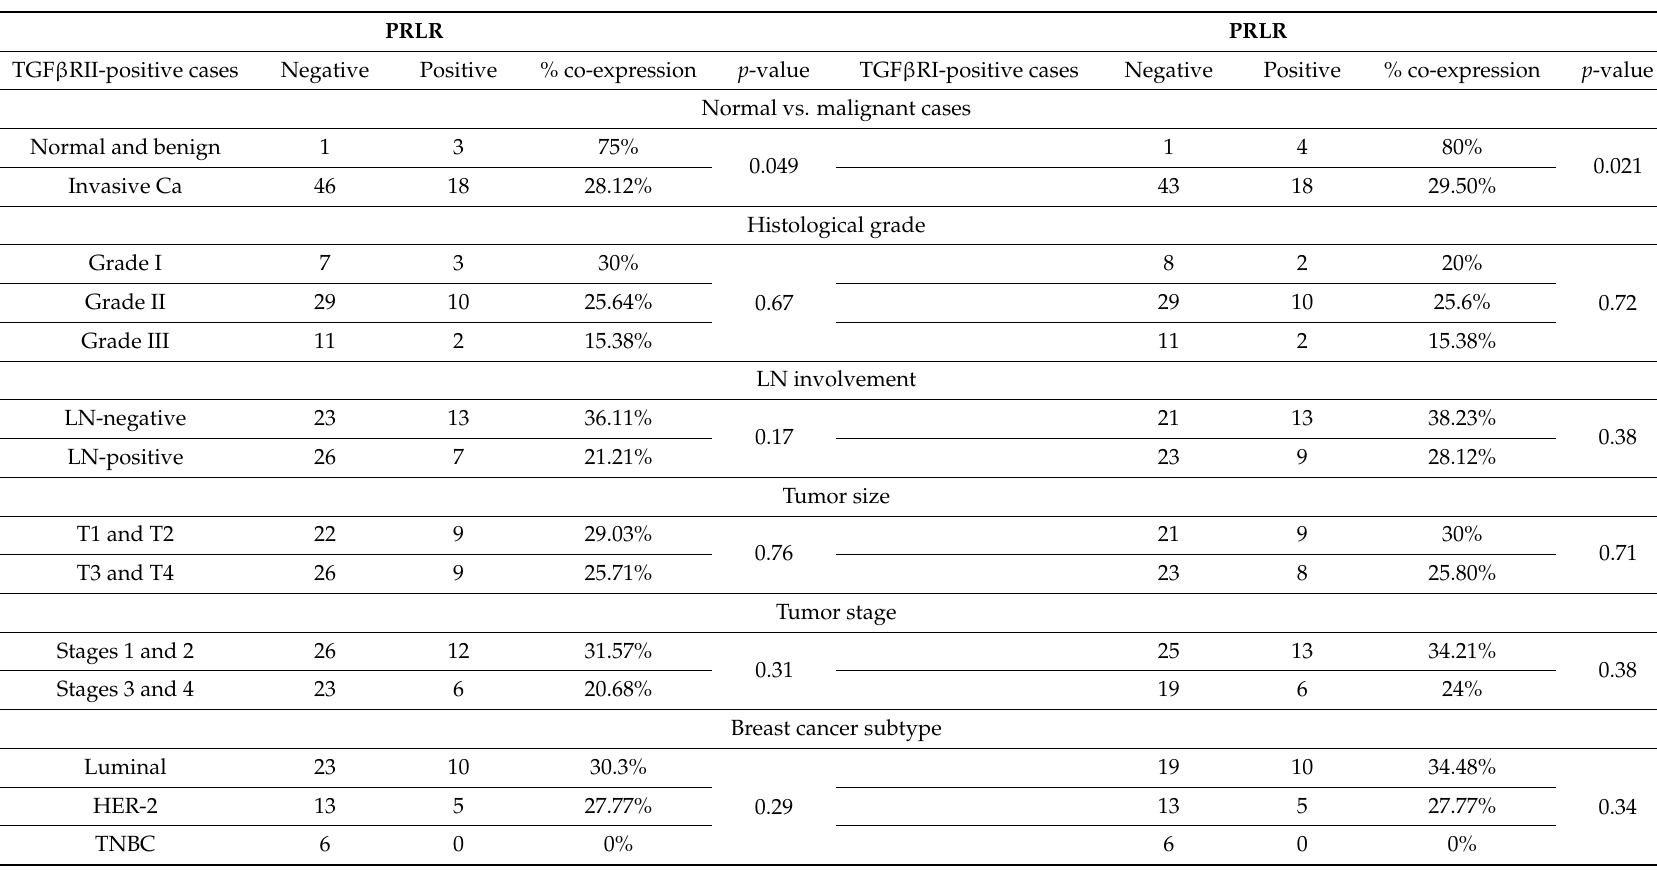
Table 1. The association between the co-expression levels of prolactin receptor and transforming growth factor β receptors (PRLR/TGF β RI and PRLR/TGF β RII) in relation to clinicopathological parameters. PRLR PRLR TGF β RII-positive cases Negative Positive % co-expression p -value TGF β RI-positive cases Negative Positive % co-expression p -value Normal vs. malignant